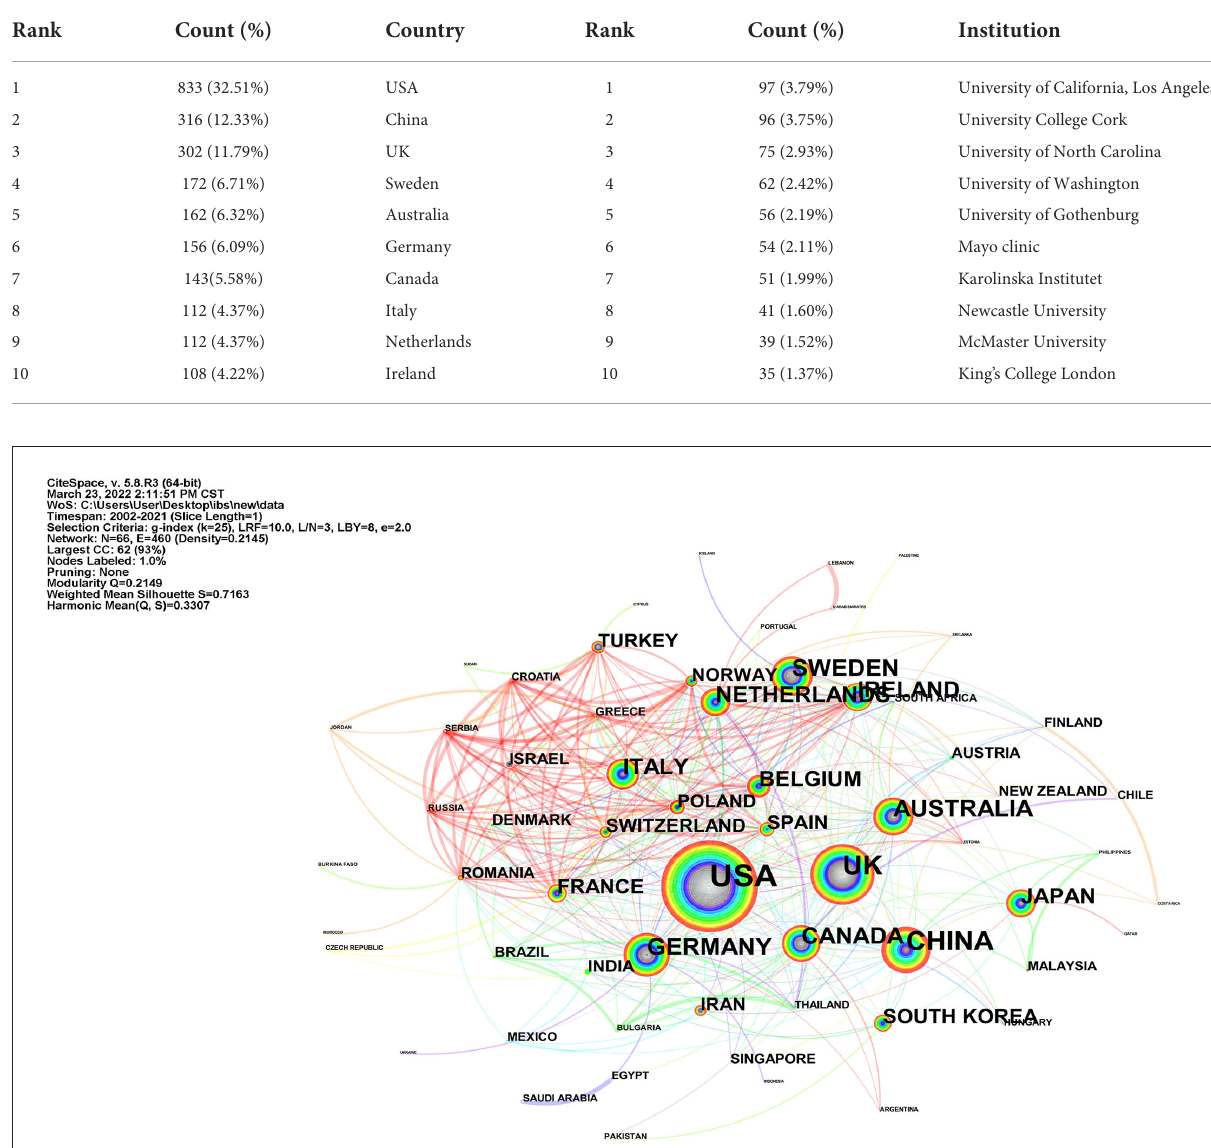
TABLE 2 Top 10 countries and institutions contributed to the publications.